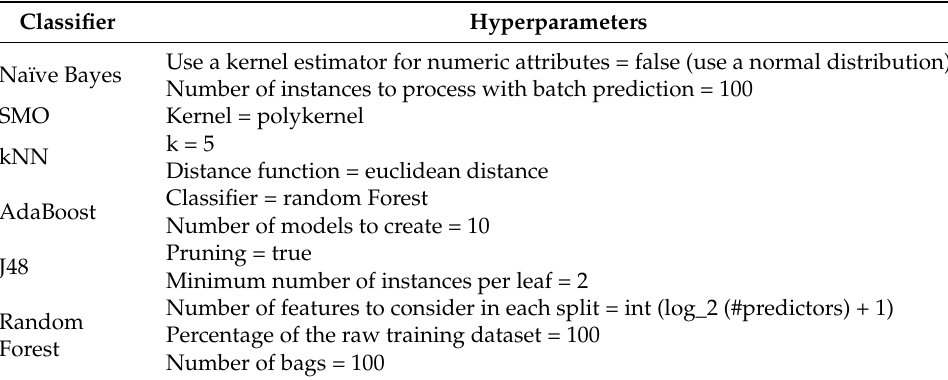
Table 7. Hyperparameter optimization of classification